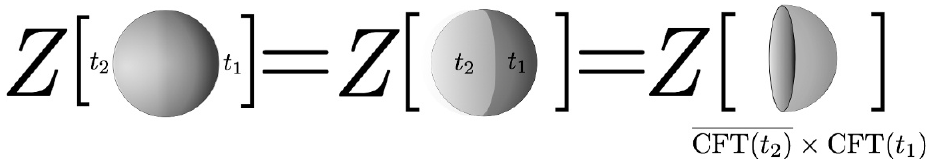
Figure 1 . The expectation value of the Janus interface with a smooth pro(cid:12)le of couplings coincides with that of zero width. Upon folding, it is then identi(cid:12)ed with the hemisphere partition with a particular boundary condition for a product